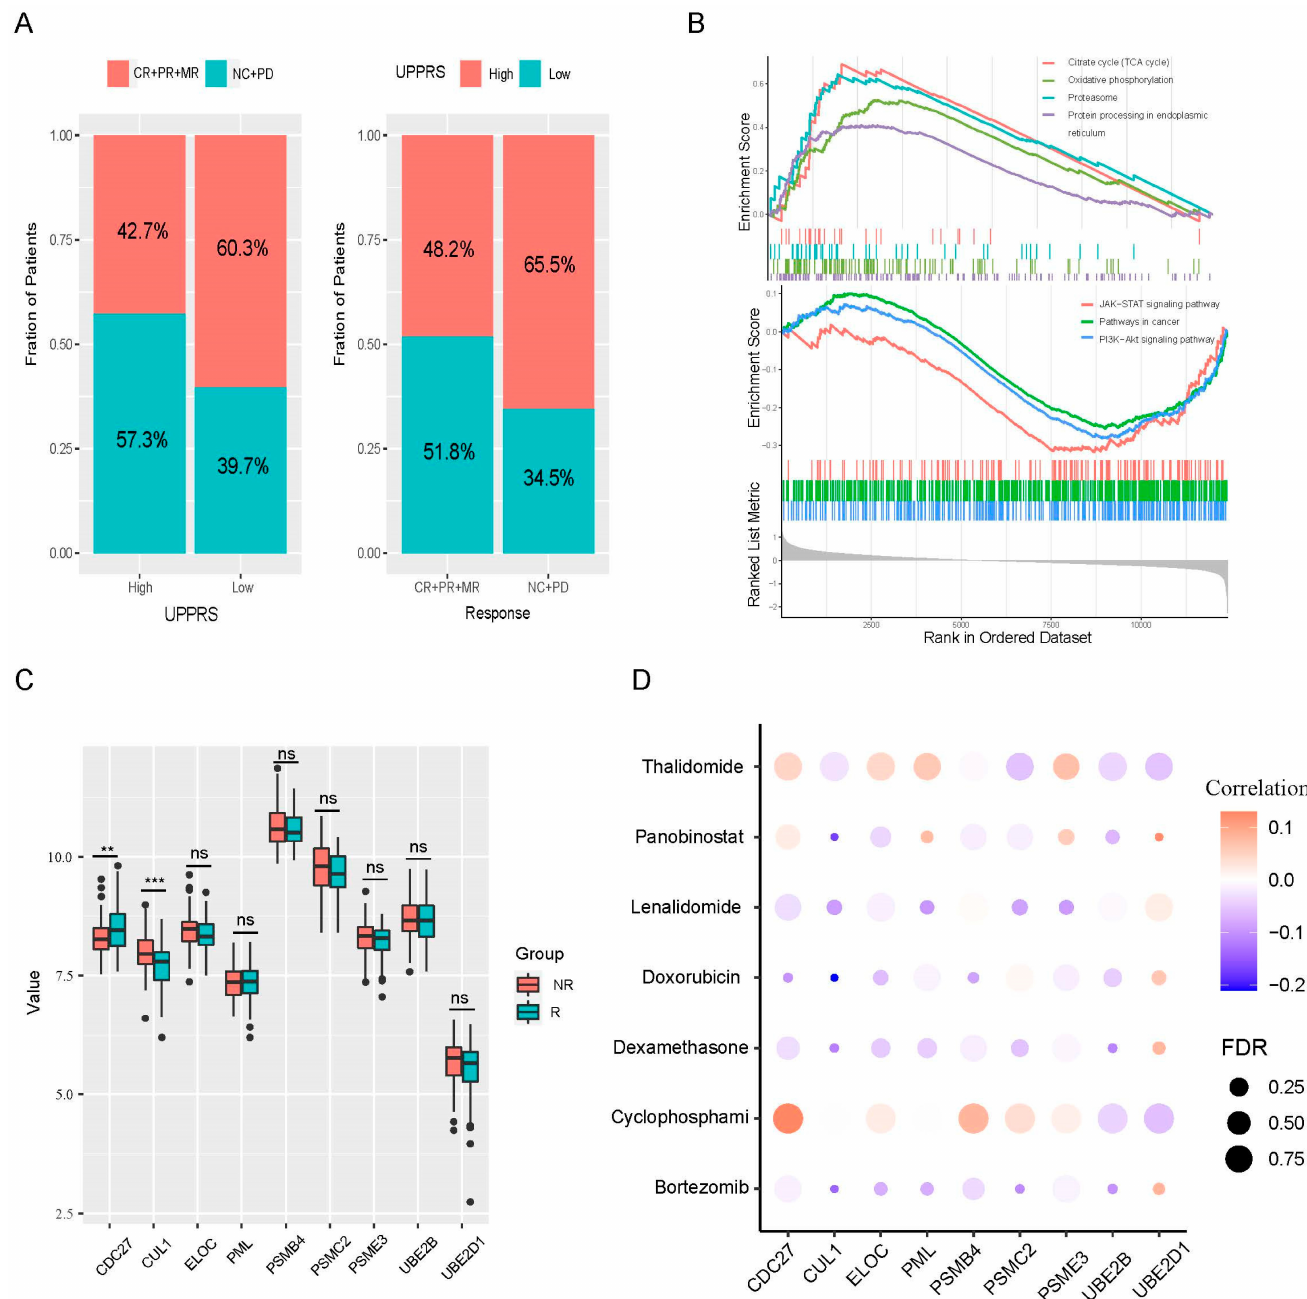
Figure 4. UPPRS can predict the response trigged by PIs. ( A ) The association between UPPRS and clinical response to bortezomib. ( B ) Pathways with significant enrichment in different UPPRS groups in the training group. ( C ) The expression of nine UPPGs in the different response groups in the training cohort. ( D ) The relationships between gene signature expression and common drugs used for MM. PIs, proteasome inhibitors; PD, progression disease; NC, no change; MR, minimal response; PR, partial response; CR, complete response. ** p < 0.01; *** p < 0.001, ns: no